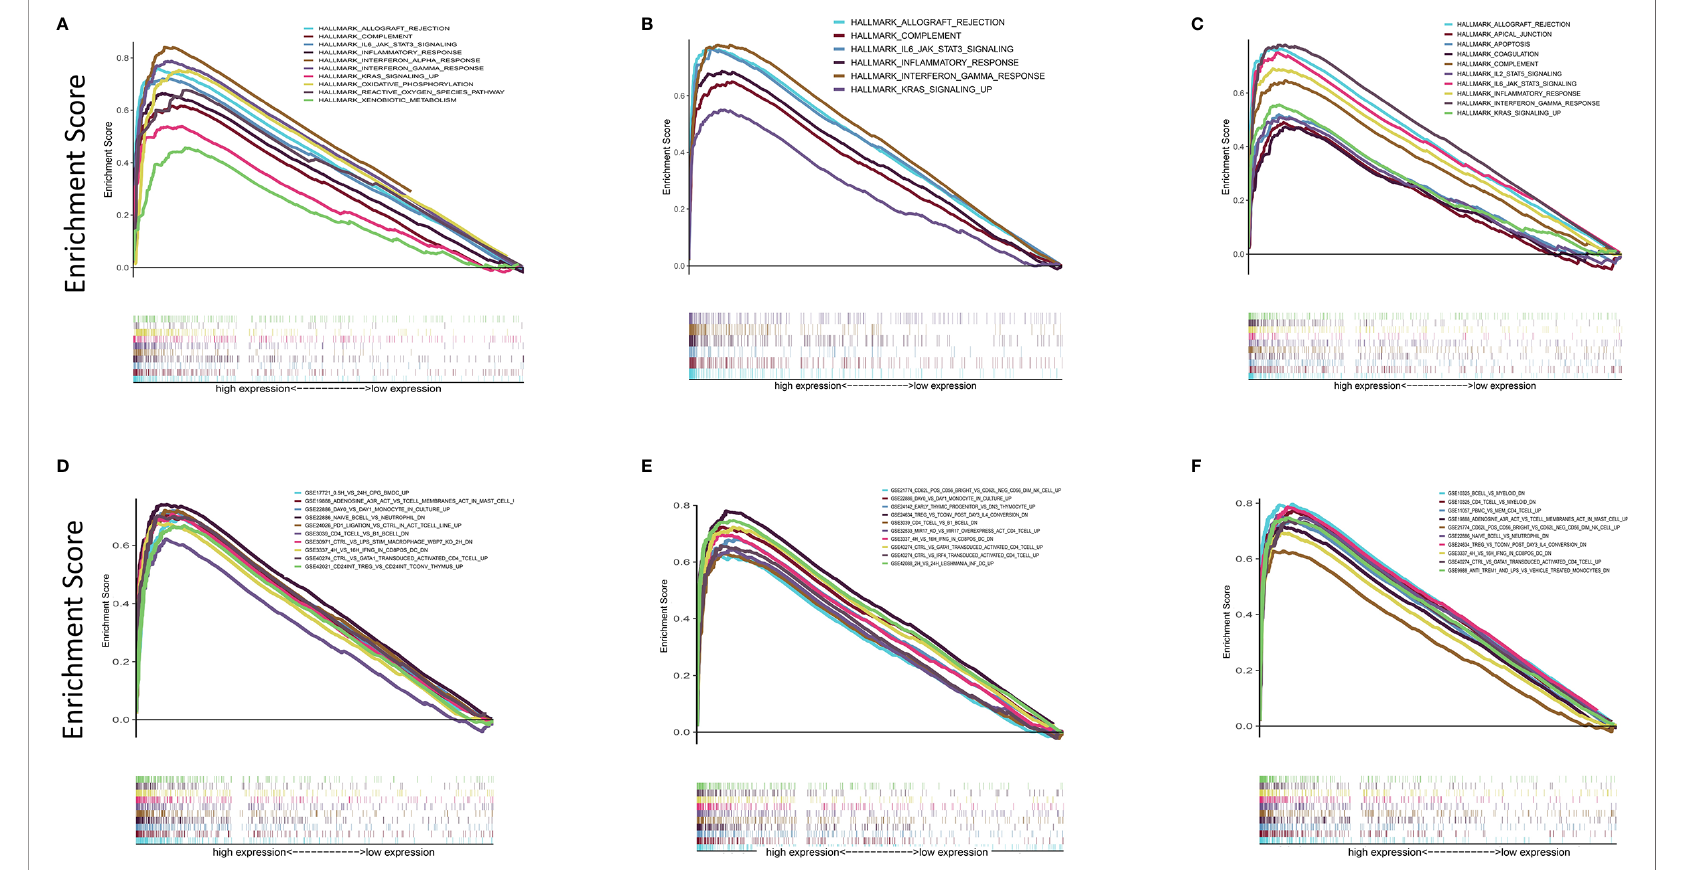
FIGURE 6 | GSEA of samples with high and low C1qA, C1qB and C1qC expression. (A – C) C1qA, C1qB and C1qC are associated with the gene set enriched in HALLMARK. Each line represents a speci fi c set of genes, with the upregulated genes located at the origin near the coordinates on the left and the downregulated genes located on the right side of the x-axis. FDR q < 0.05 and NOM p < 0.05 were considered signi fi cant. Only a few leading gene sets are displayed in the fi gure panels. (D – F) Expression of genes in the C7 gene set (immunological gene set) in samples strati fi ed by C1qA, C1qB or C1qC expression. Only a few gene sets with high NOM and FDR values are